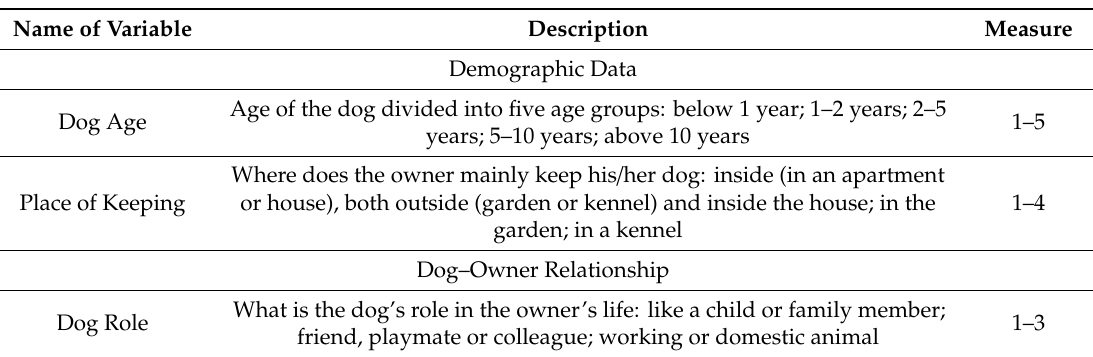
Table 1. The independent variables derived from each part of the questionnaire. In the last column, we indicated the levels of measure the given variable could take in the statistical